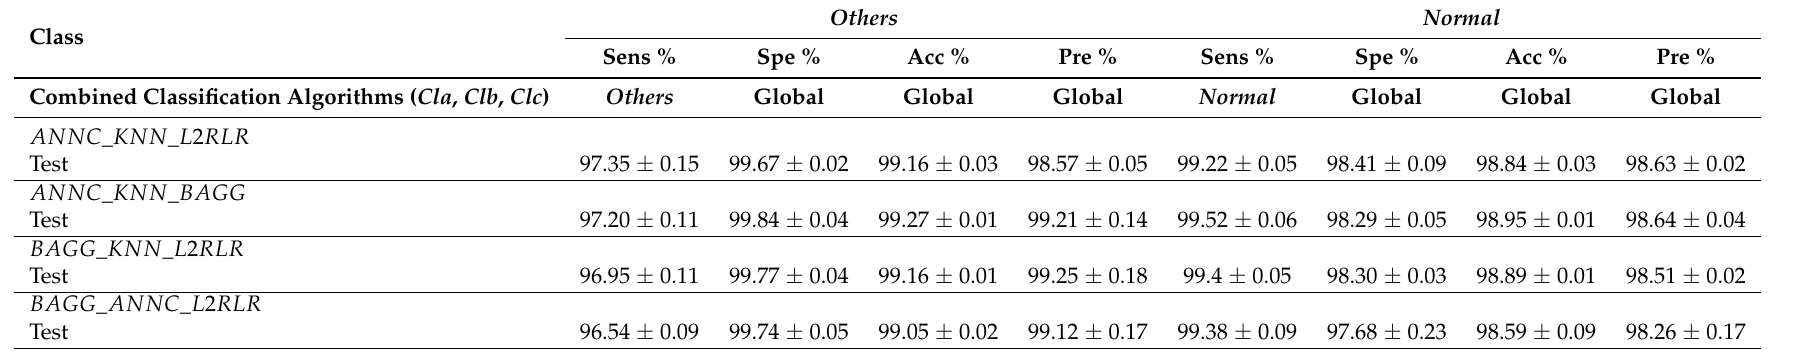
Table 6. Results for the VMM combination method using TFRI as data input. Results correspond to detection of Other and Normal